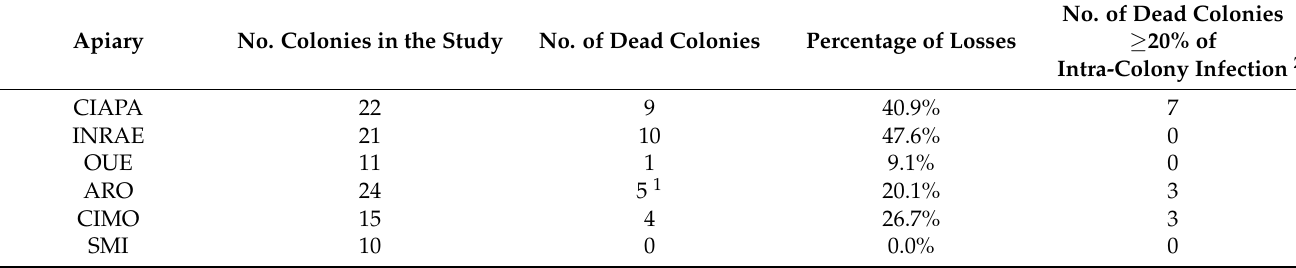
Table 7. Total number of colonies studied per apiary and colony mortality.